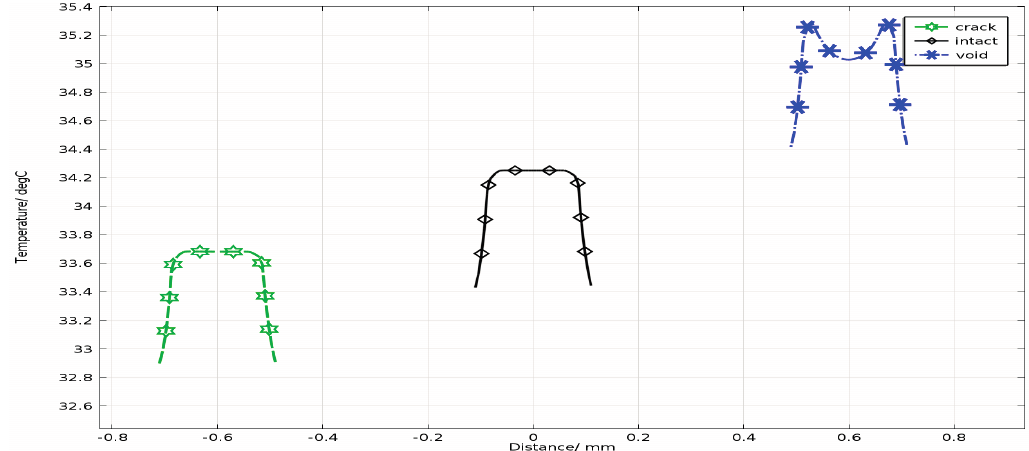
Figure 5. Temperature distribution at each point along the